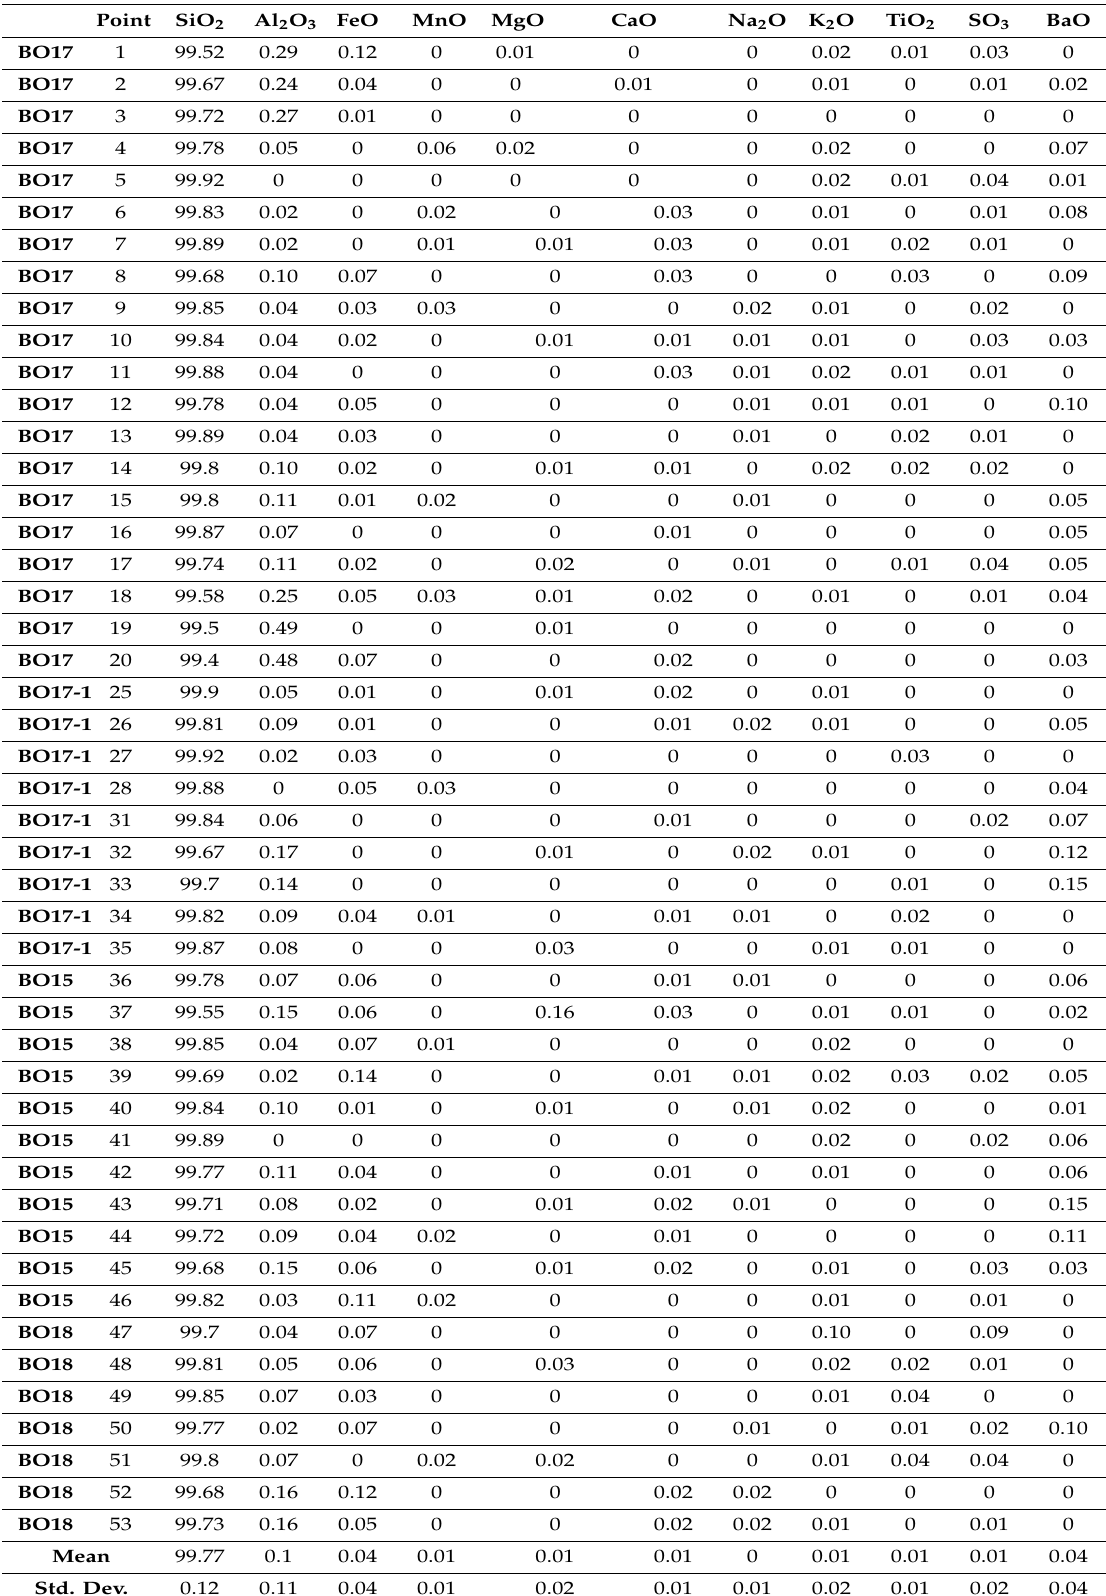
Table 1. Microprobe analyses of quartz crystals (the values are in wt%). Numbers of measurement points are valid for Figure